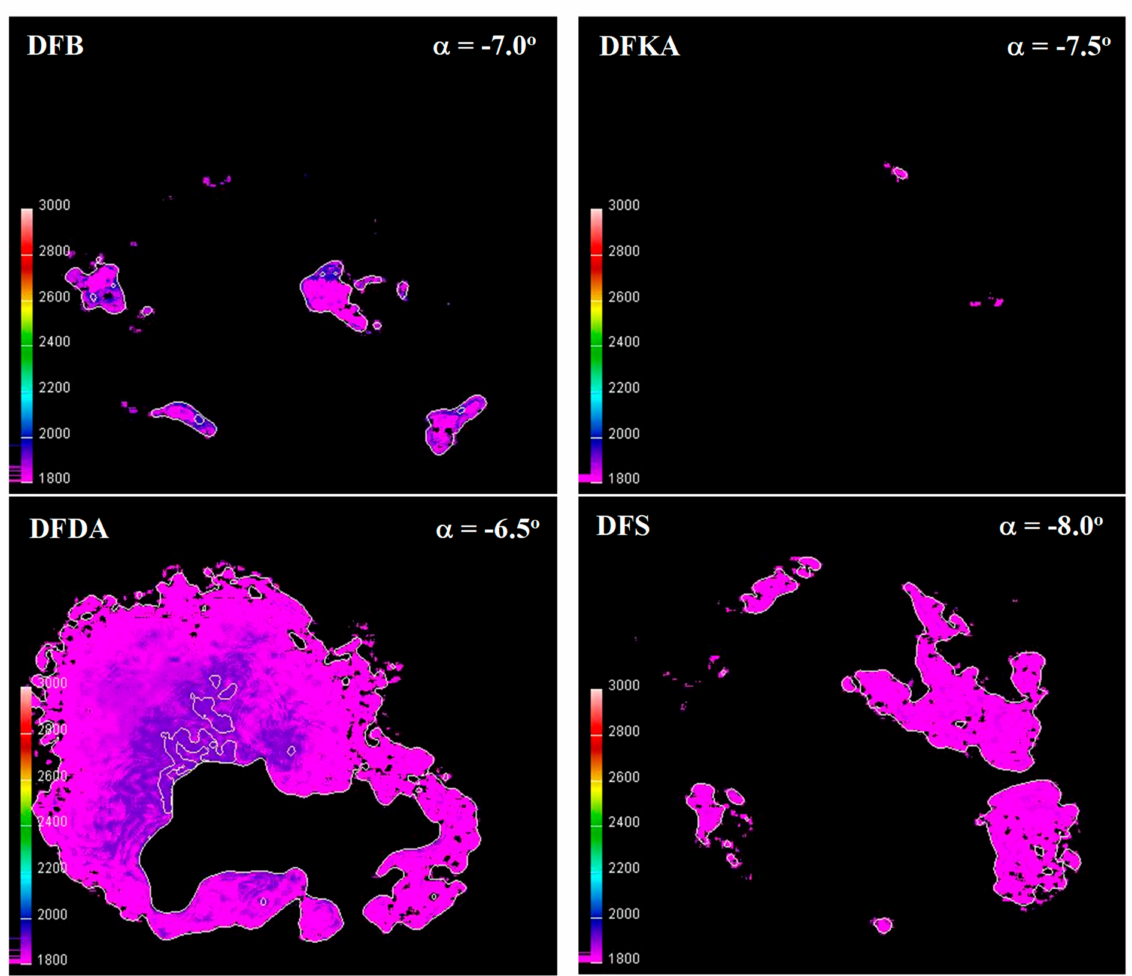
Figure 29. Distribution of isotherms in flame in engine cylinder for crankshaft angle of rotation corresponding to maximum rate of kinetic combustion α dQk_max .